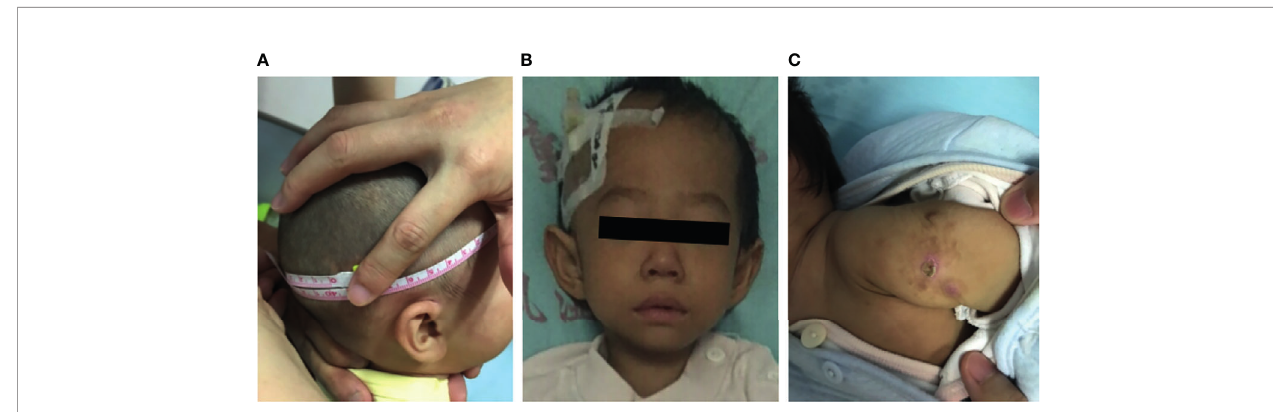
FIGURE 1 | Clinical data for patients with LIG4 de fi ciency. (A) Microcephaly in patient P9. (B) Facial dysmorphism in patient P13. (C) BCG scar ulceration and exudation in patient